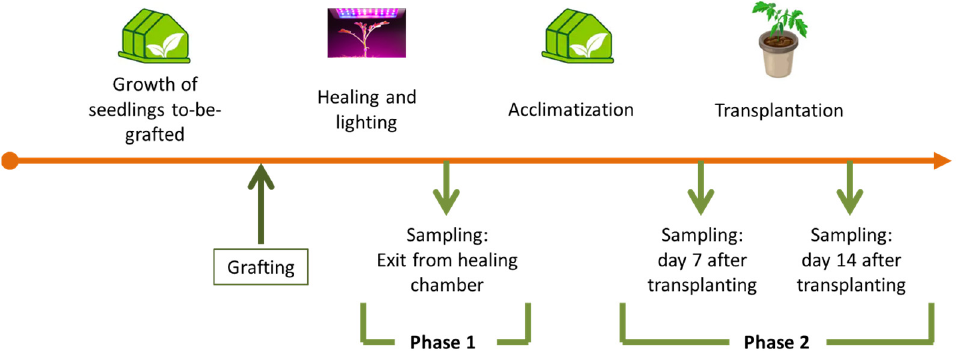
Figure 1. Schematic depiction of the growth of grafted tomato seedlings along with the sampling times in the first and second phases of our